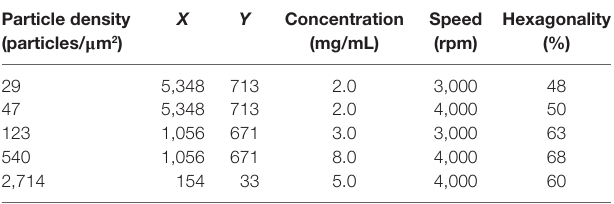
TaBle 1 | The change in the composition of styrene units ( x ) and vinylpyridin units ( y ) enables the preparation of nanostructured surfaces with different particle